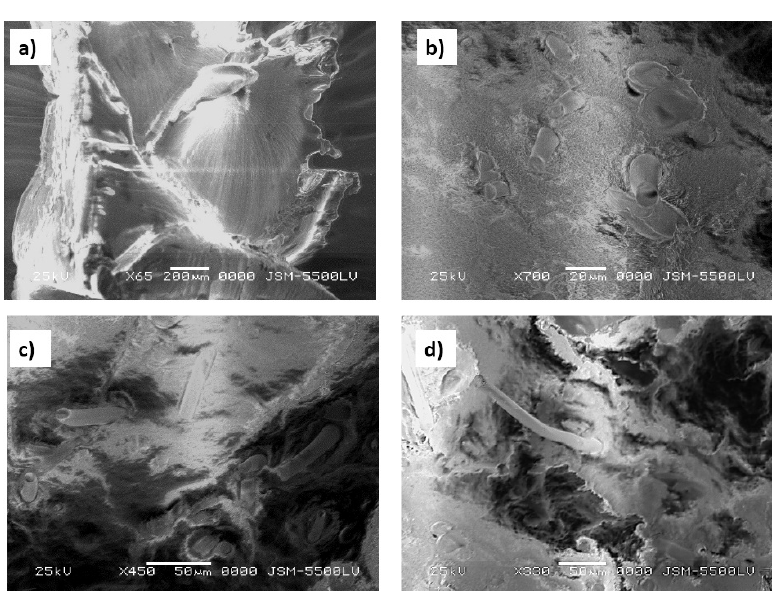
Figure 9. Impact fracture toughness variation with wt % SBF.